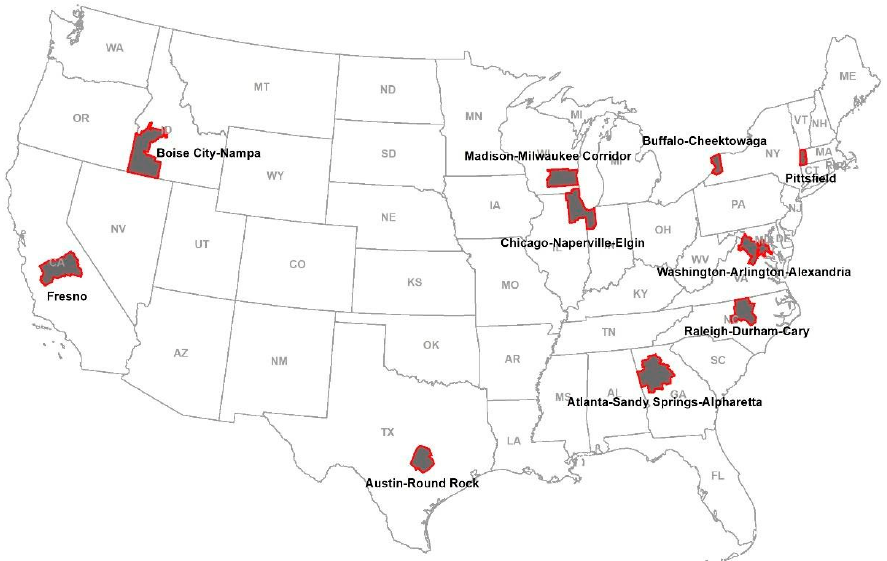
Figure 5. Distribution of 10 selected cities/metropolitans for accuracy assessment.